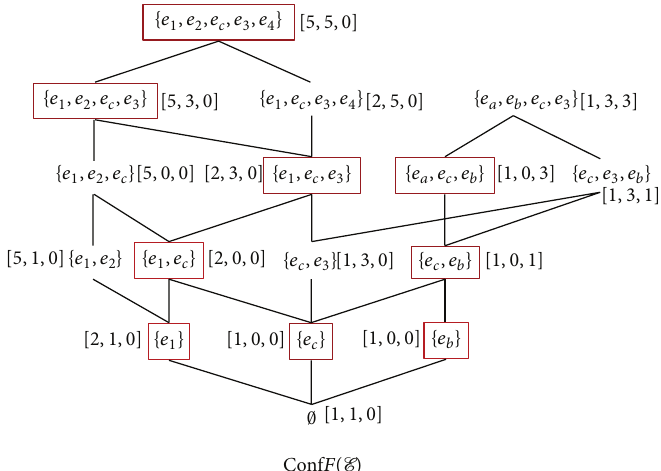
Figure 3: Family of configurations of E .